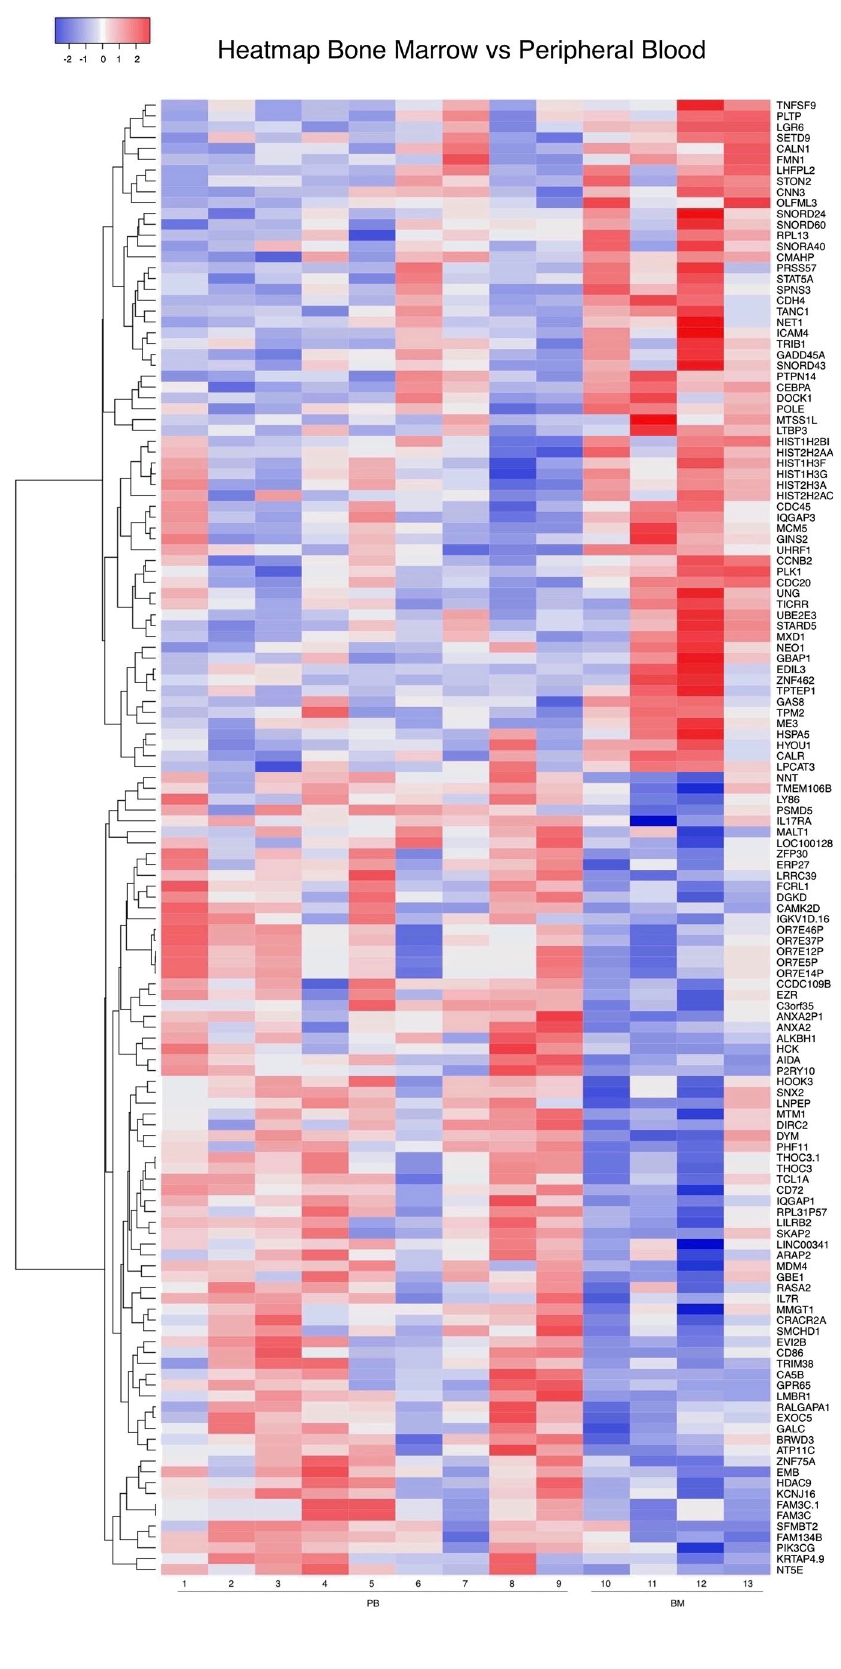
Fig. 2 Global gene expres- sion microarray. Heatmap of CD10 + /CD19 + pre-B lymphoblasts from peripheral blood (PB; n = 9) and bone marrow (BM; n = 4) samples of patients newly diagnosed with B-ALL. Data of the 136 differentially expressed genes (DEG): 62 upregulated (red) and 74 downregulated genes (blue) were used to create a heatmap with the HeatMap- per tool using the clustering method centroid linkage and distance measurement with Pearson’s correlation coef-